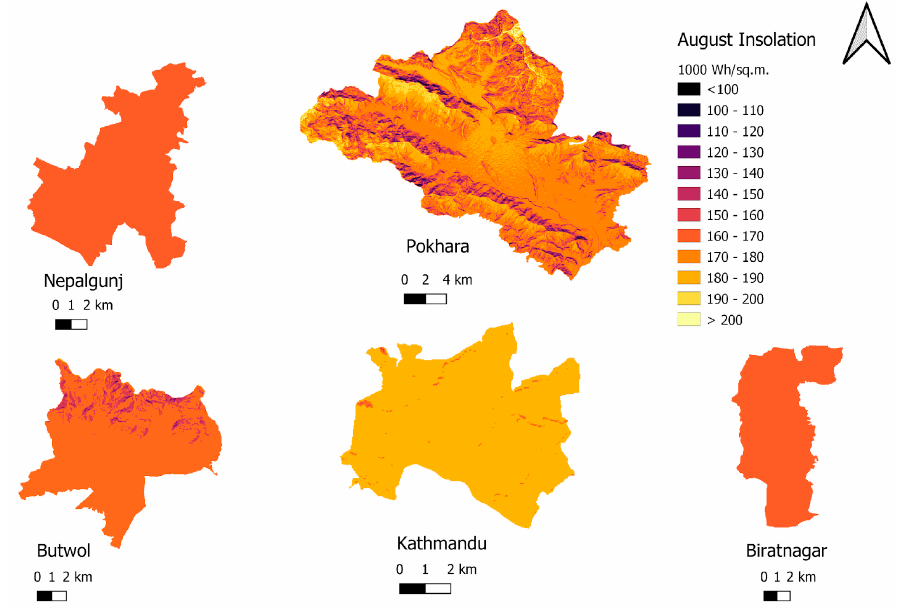
Figure 5. Spatial insolation variation in selected cities in Nepal during August.